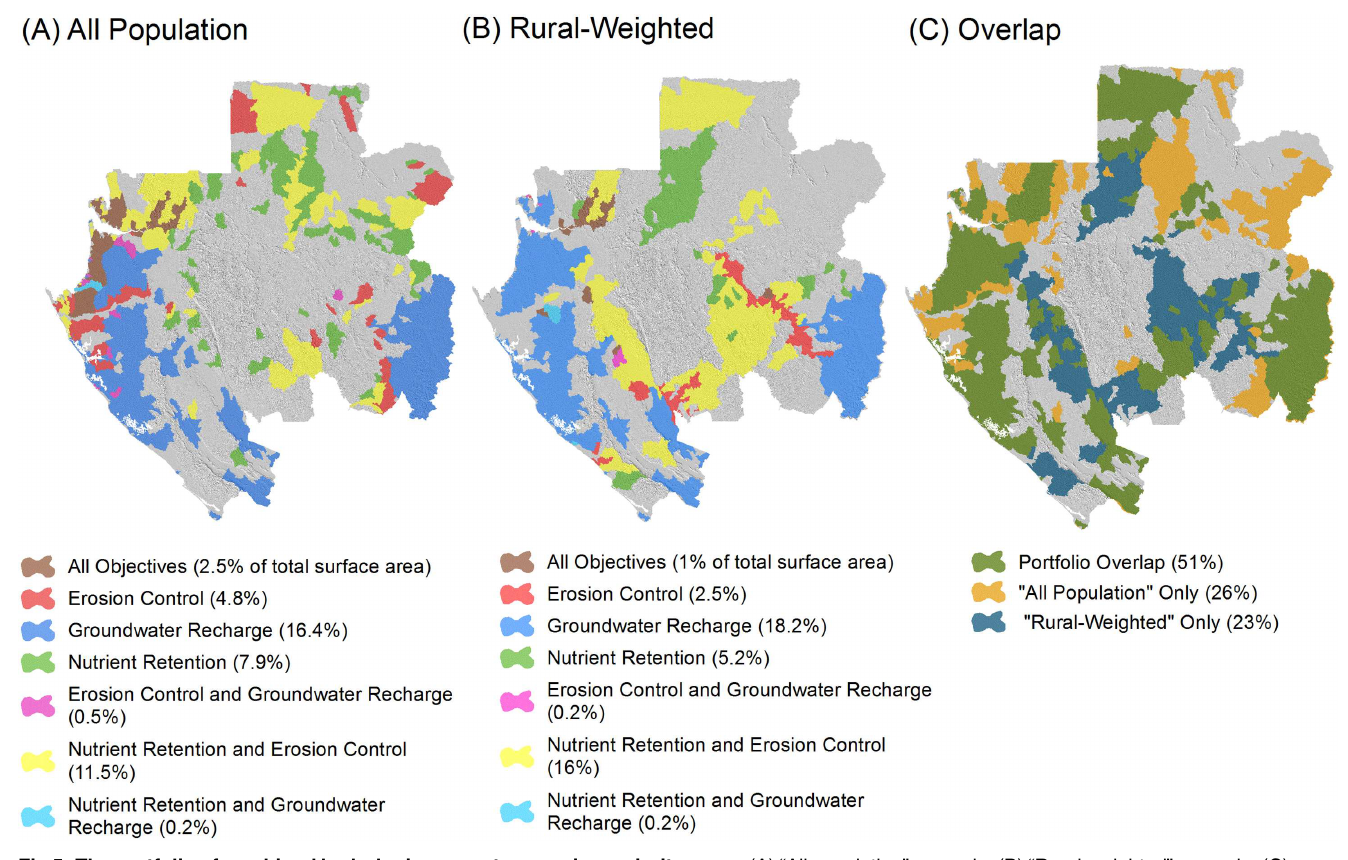
Fig 5. The portfolio of combined hydrologic ecosystemservicespriority areas. (A) “All population” scenario. (B) “Rural-weighted” scenario. (C) Overlap betweenthese scenarios.For (A) and (B), percentage areas (of the total country area) are reportedfor each uniquecombination of the HES objectives. For (C), the percentage area of overlap and separation is reportedacross the two